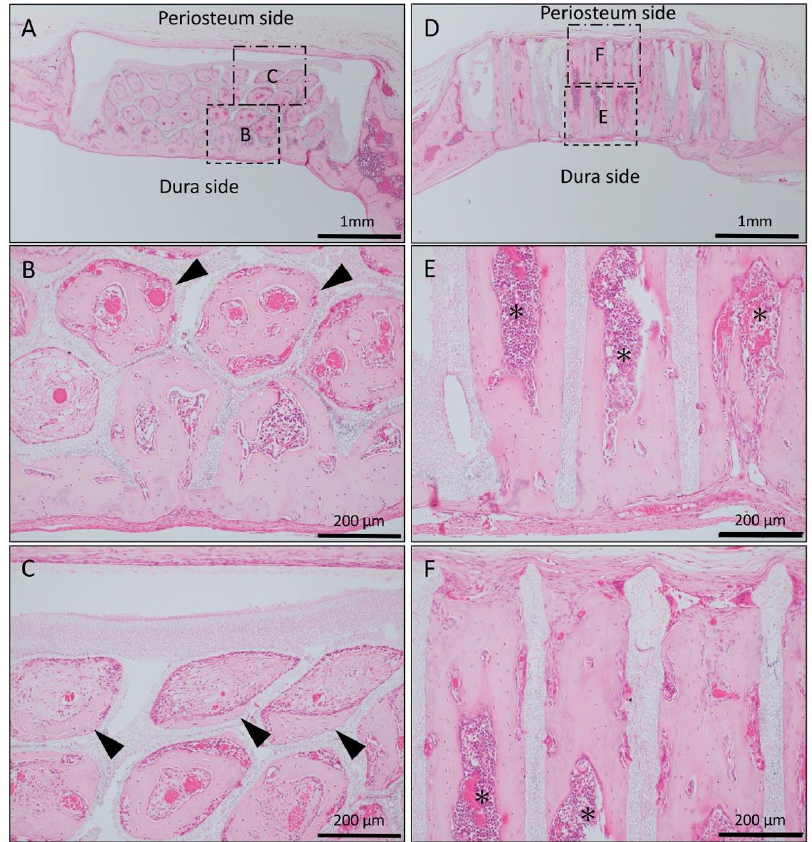
Figure 3. Histological images of β-TCP with Matrigel + bone morphogenetic protein-2(BMP-2) at 4 weeks after implantation. ( A ) Low-magnification image of horizontal β-TCP. No inflammatory granulation tissue was observed around β -TCP. ( B , C ) Higher-magnification image of corresponding outlined area in (A). New bone formation extended to the upper part of the holes and was observed from the dura side to the periosteum side as added to the inner wall of the holes (black arrowheads). ( D ) Low-magnification image of vertical β -TCP. ( E , F ) Higher-magnification image of corresponding outlined area in (D). Vigorous new bone formation was observed up to the upper part along the TCP holes, and almost all vertical holes were filled with vigorous new bone tissue. In addition, the formation of bone marrow-like tissue (asterisks) and vascular cavity was observed in the area surrounded by bone